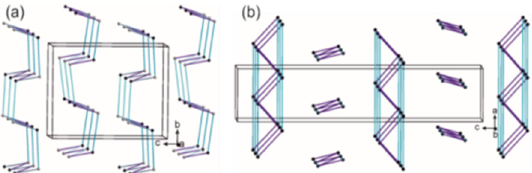
Figure 16. Simplified hydrogen-bonded networks in DKP perindopril erbumine orthorhombic ( a ) and tetragonal ( b ) polymorphic structures. The black and gray dots represent a center of gravity of crystallographically independent molecules, blue-shaded lines stand for weak C-H … O hydrogen bonds.